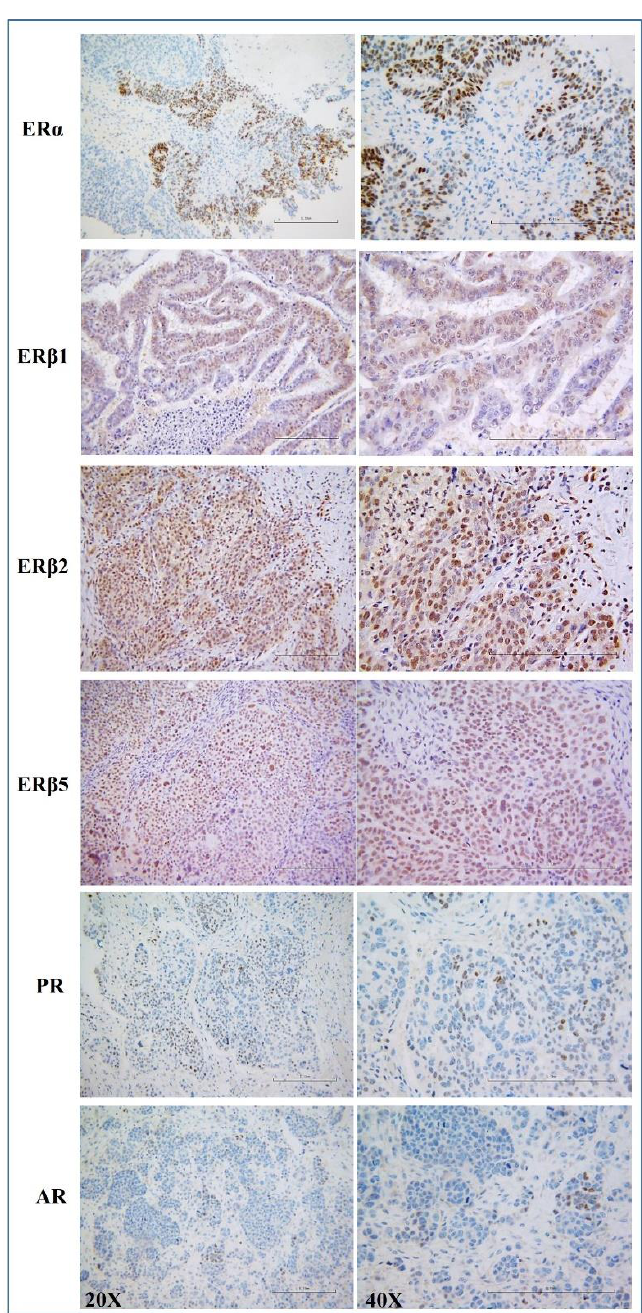
Figure 1. Immunohistochemical analysis of six hormone receptors in primary high-grade serous ovarian cancer (HGSOC). Representative pictures for ERα, ERβ1, ERβ2, ERβ5, PR , and AR im- munostaining in HGSOC patients (magnification 20×, 40×), displaying both nuclear and cytoplasmic protein expressions.